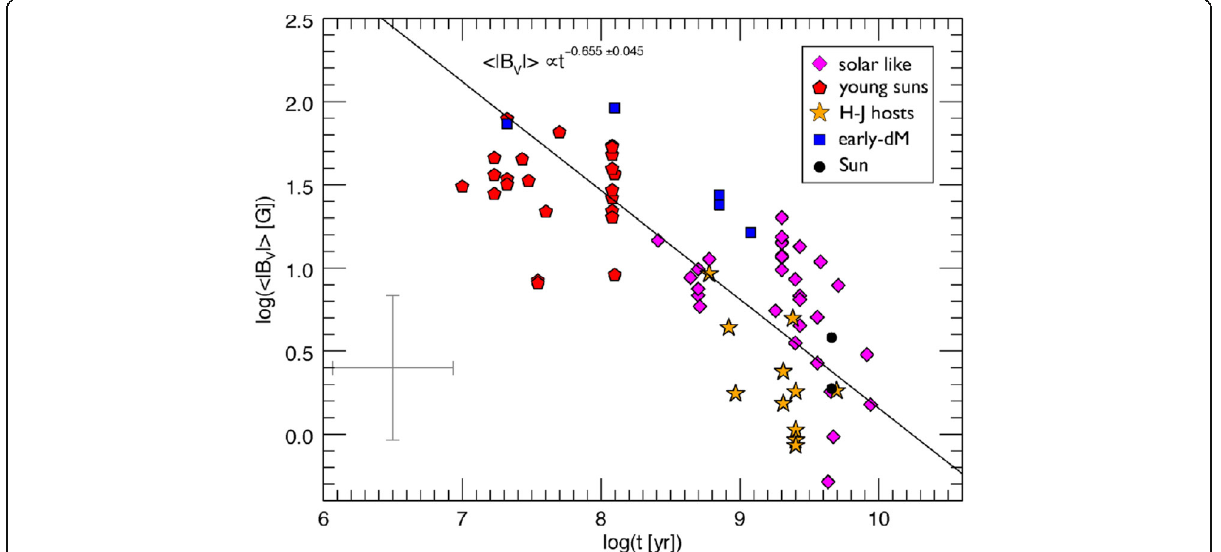
Fig. 12 Evolution of stellar magnetic activity with age (reproduced from Vidotto et al. 2014). The large-scale magnetic field is measured in this sample of stars utilizing the Zeeman Doppler Imaging technique and shows a power law dependence between magnetic activity (y-axis) and age (x-axis). These observations of stronger magnetic output at young stellar ages suggest that the environment of the early, young Sun was relatively extreme, with more energetic storms, winds, and radiative output creating an intense space environment for Earth and other solar system